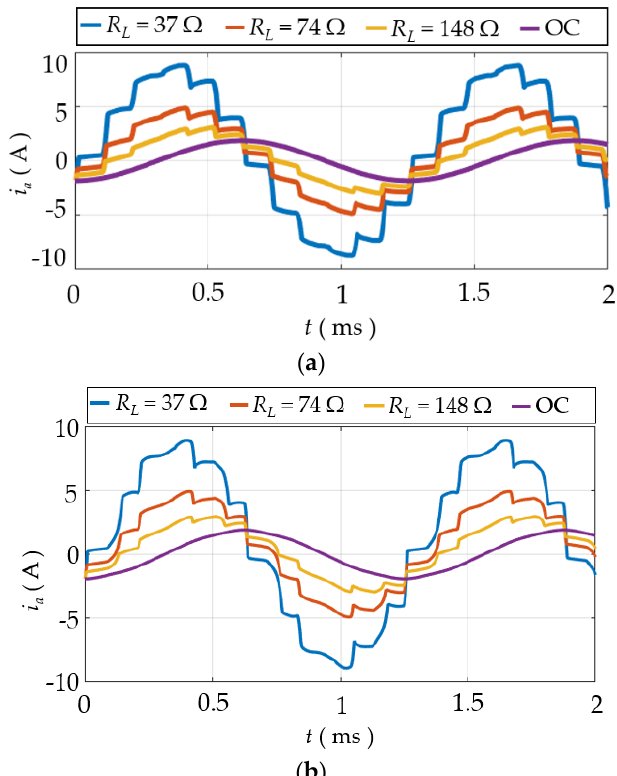
Figure 6. CTU input current waveforms. ( a ) Nominal condition. ( b ) Distorted input voltage.